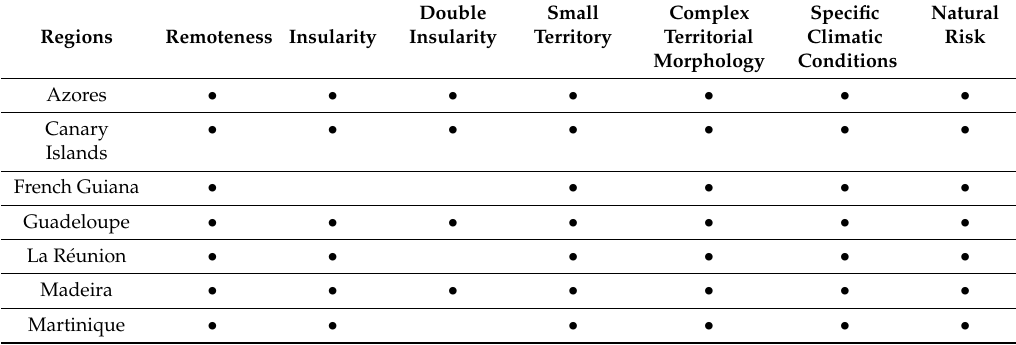
Table 9. Major geographical limitations of insular regions—adapted from EU—European Parliament [43,44].